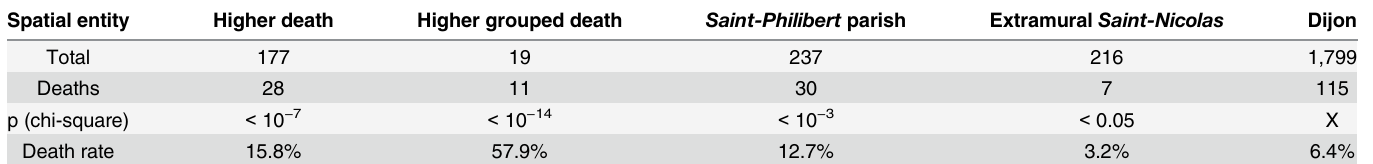
Table 6. Excess deaths in the southwest of Dijon in